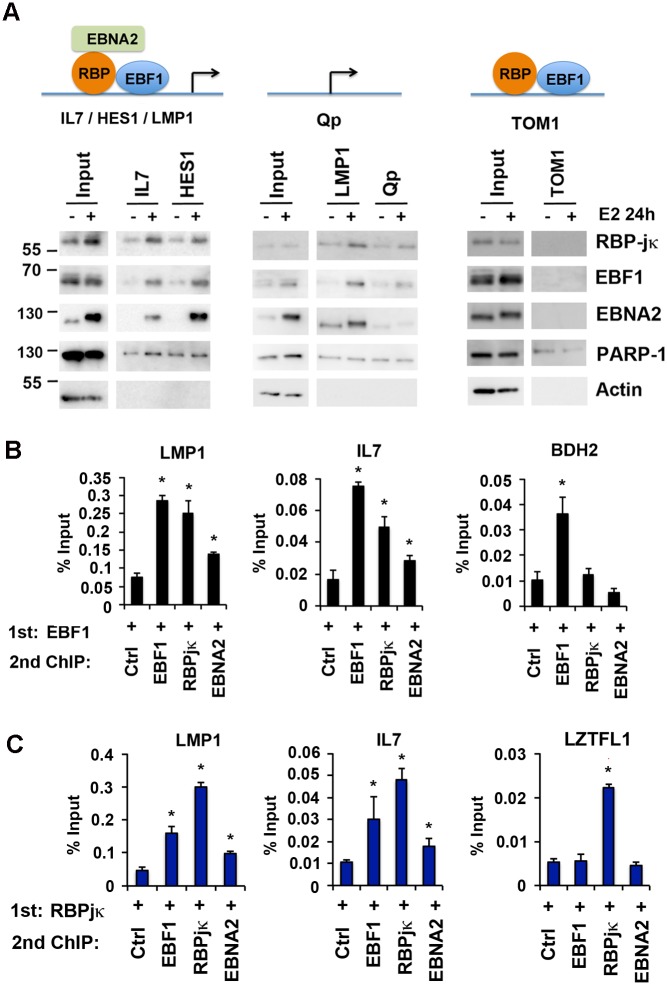
Cooperative binding and colocalization of EBF1, RBP-jκ, and EBNA2 at DNA regulatory elements.
(A) DNA-affinity binding assays with nuclear extracts from EREB2.5 cells with (+) or without (-) estradiol (E2) using DNA regulatory elements from IL7, HES1 (left), or LMP1, Qp (middle), or TOM1 (right). Input (10%) is indicated, and bound proteins were assayed by Western blot for EBF1, RBP-jκ, EBNA2, and specificity controls for PARP1 and Actin. (B) ChIP-reChIP assays in LCLs with EBF1 as first ChIP, followed by a reChIP with either no antibody control or antibody to EBF1, RBP-jκ or EBNA2. ReChIP DNA was quantified by qPCR at LMP1, IL7, and BDH2 (an EBF1 only site) binding sites. (C) Same as in B, except first ChIP was with RBP-jκ followed by a ReChIP with no antibody control, or EBF1, RBP-jκ, or EBNA2 antibody and assayed at LMP1, IL7, or LZTFL1 (an RBP-jκ only site) binding sites. Asterisk indicates p < 0.05.